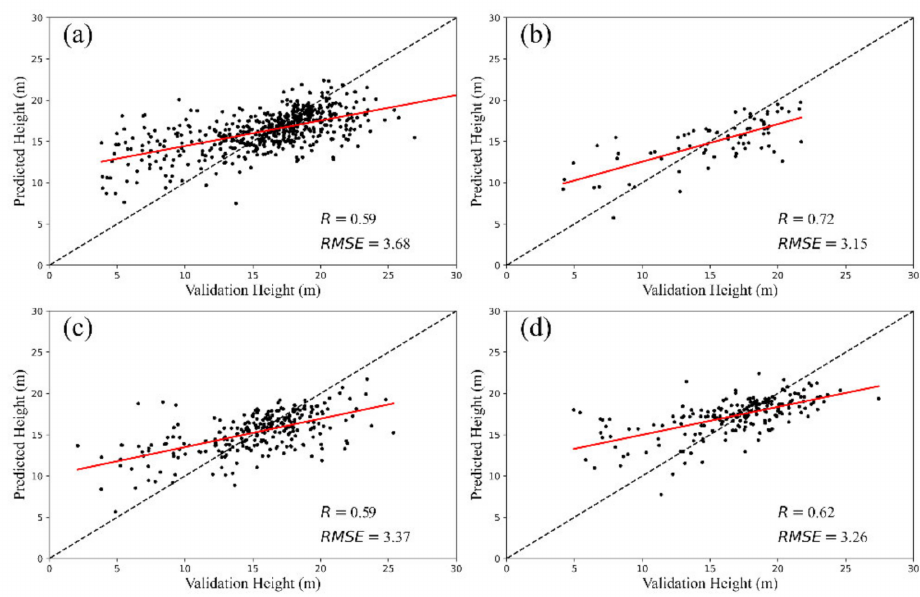
Figure 3. Correlations between the validation samples and predicted forest canopy heights by